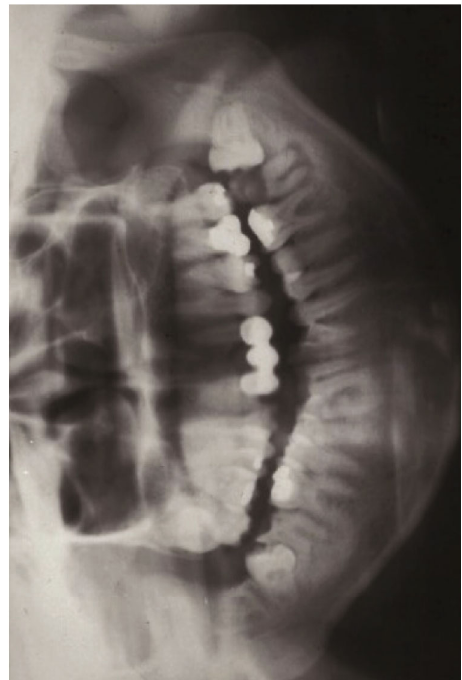
Figure 5: Tooth #17 was transplanted into the #18 site. Interrupted sutures were rendered to proximate the gingival tissues.